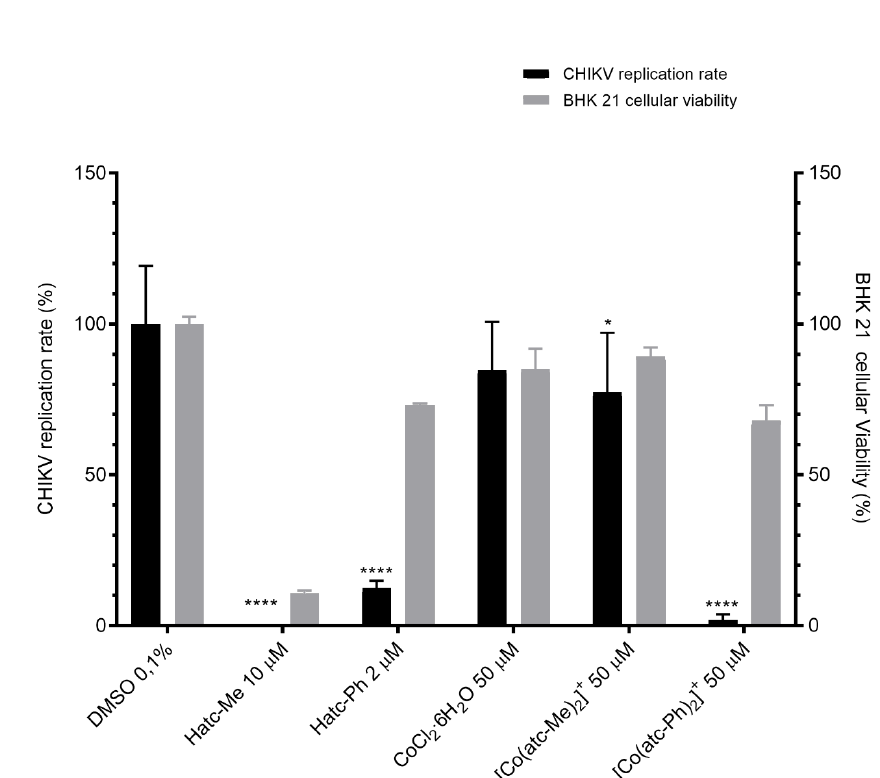
Figure 4. Activity of compounds on chikungunya virus (CHIKV) infection and viability of baby hamster kidney (BHK) 21 cells. BHK 21 cells were infected with CHIKV nanoluc and simultaneously treated with the compound. After 16 h post-infection (p.i.), cells were lysed, and a Renilla luciferase assay was performed to assess CHIKV replication rates. In parallel, a 3-(4,5-dimethylthiazol-2-yl)-2,5-diphenyl tetrazolium bromide (MTT) assay was performed. Mean values of a minimum of three independent experiments each measured in triplicate are